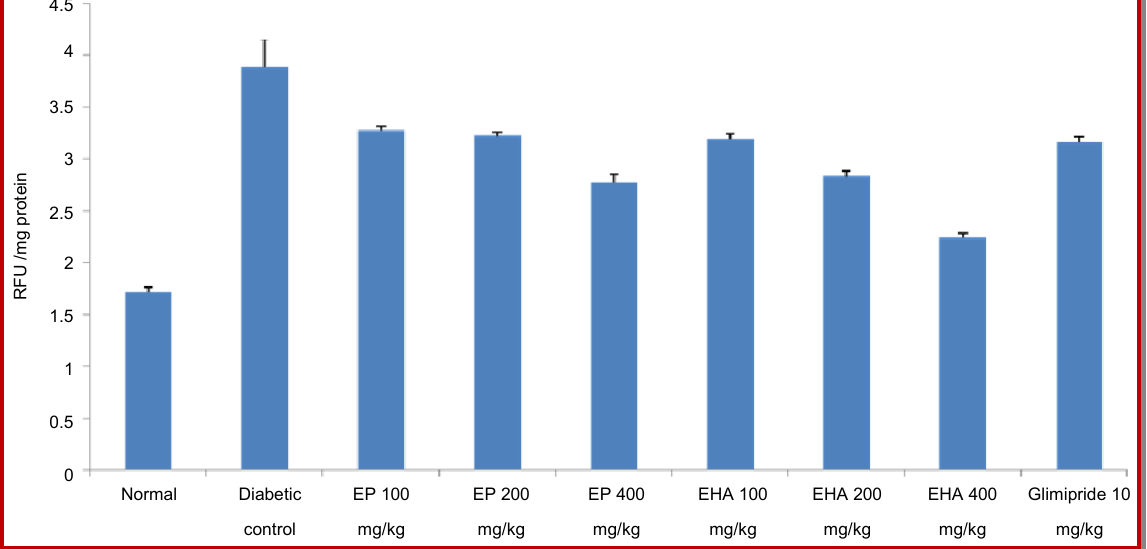
Figure 3: Effect of petroleum ether (EP) and hydroalcohol (EHA) extract on AGE’s level (RFU/mg protein). Values are repre- sented as mean ± SEM; (n = 6); Data was analyzed by using one- way ANOVA followed by Tukey’s multiple test; ‘a’ vs control,